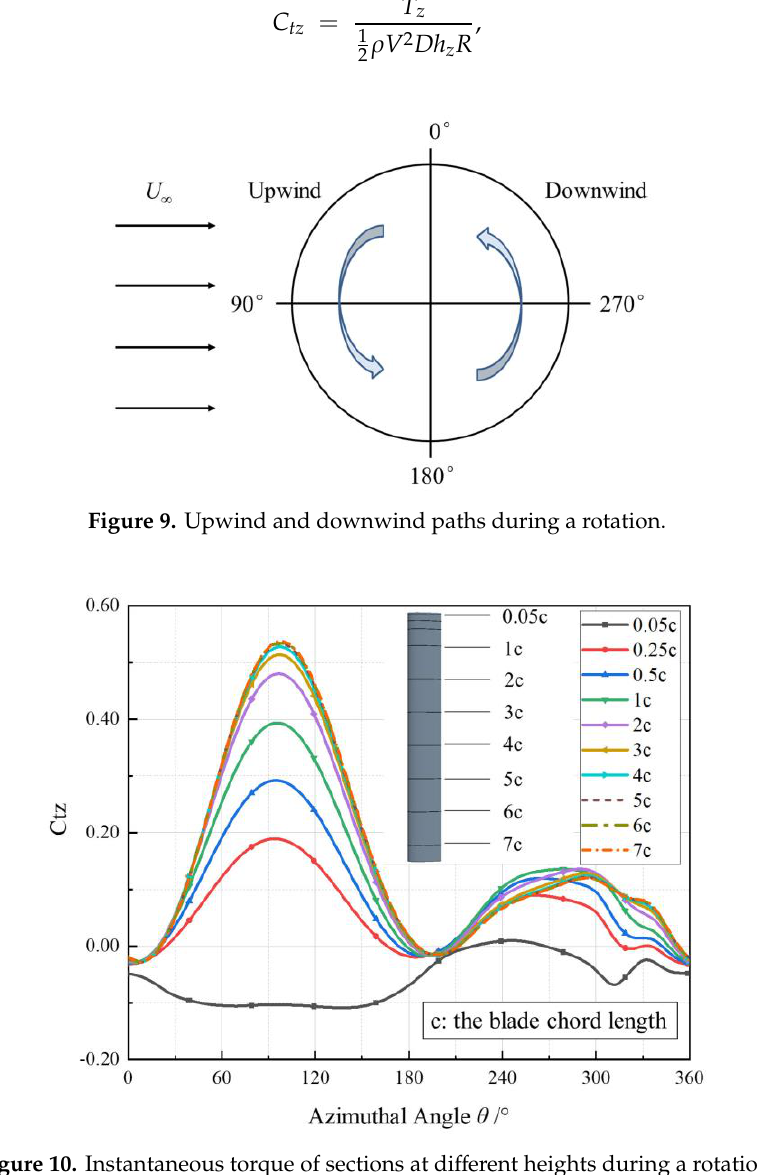
Figure 9. Upwind and downwind paths during a rotation.